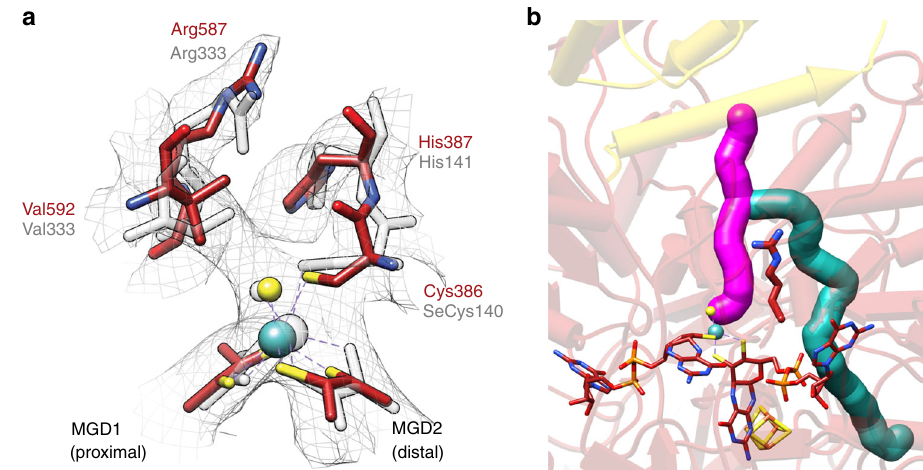
Fig. 3 The active site of Rc FDH. a Superimposition of active site structural elements of oxidised FdhF (PDB-ID: 1fdo [https://doi.org/10.2210/pdb1FDO/ pdb], transparent white) with those of the as isolated Rc FDH active site (red). The map of the as isolated structure is shown as grey mesh. b Proposed hydrophilic (pink) and hydrophobic (cyan) tunnels in Rc FDH. FdsA (red) and FdsD (gold) subunits are depicted as pipes and planks with Arg587, bis-MGD and cluster A1 shown as